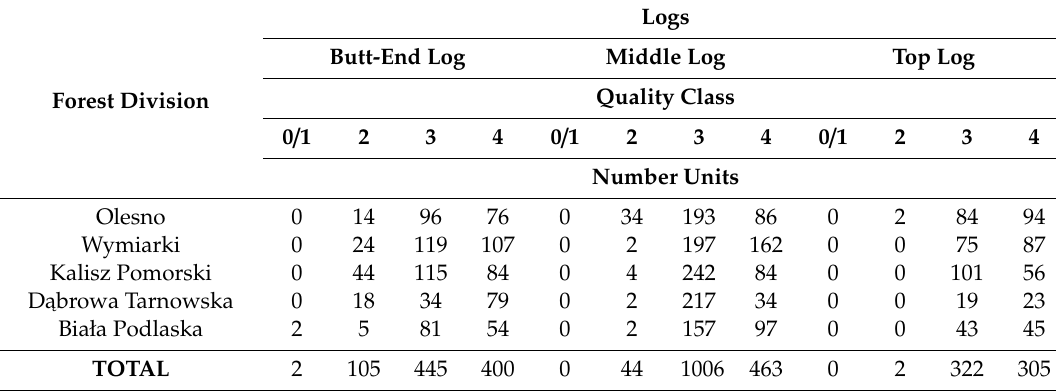
Table 14. Amount of sawn timber by defect: knots (PN-EN 1611-1).